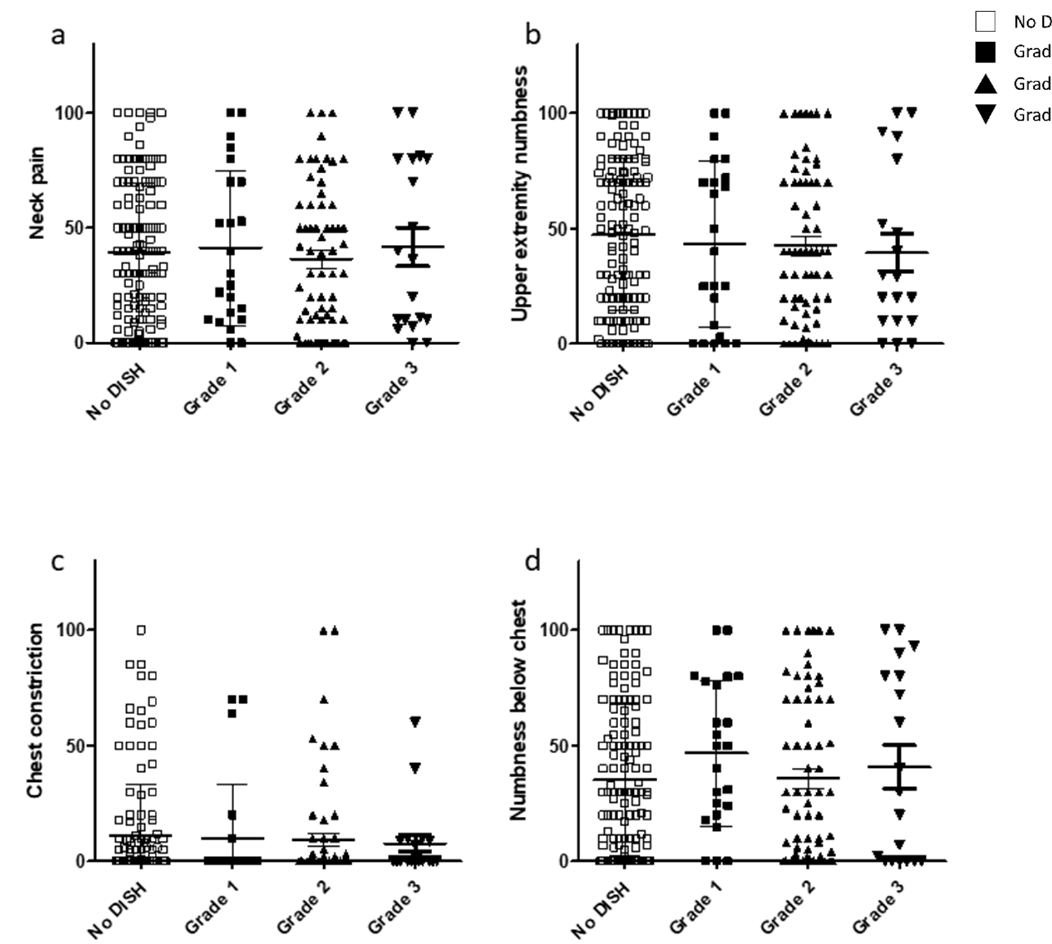
VAS scores from the JOA-CMEQ and JOA-BPEQ were investigated to clarify the relationship between degree of DISH and pain associated with cervical myelopathy. How- Data are expressed as the mean ± standard deviation or as the percentage, DISH, diffuse idiopathic ever, no significant difference was found in the VAS scores among the three DISH grades skeletal hyperostosis; OPLL, ossification of the posterior longitudinal ligament; * Significant at p < (Figures 5 and 6). 0.05.